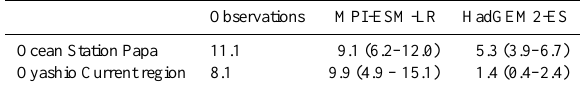
Table 2. Comparison of decadal standard deviations of [O 2 ] (µmolkg − 1 ) between observations and CMIP5 piControl experi- ments at Ocean Station Papa in the Eastern North Pacific (50 ◦ N, 145 ◦ W, σ = 26 . 9, ∼ 250–350m) and the Oyashio Current re- gion in the Western North Pacific (39–42 ◦ N, 143–145 ◦ E, σ = 26 . 9, ∼ 400–450m). piControl output from MPI-ESM-LR and HadGEM2-ES is sampled to calculate multiple estimates of decadal standard deviations for each time series. The mean and (10th–90th) percentile ranges of piControl estimates are shown. Observations are detrended using a linear fit to extract variability. Drift has been removed from the control integration of HadGEM2-ES as described in Sect.